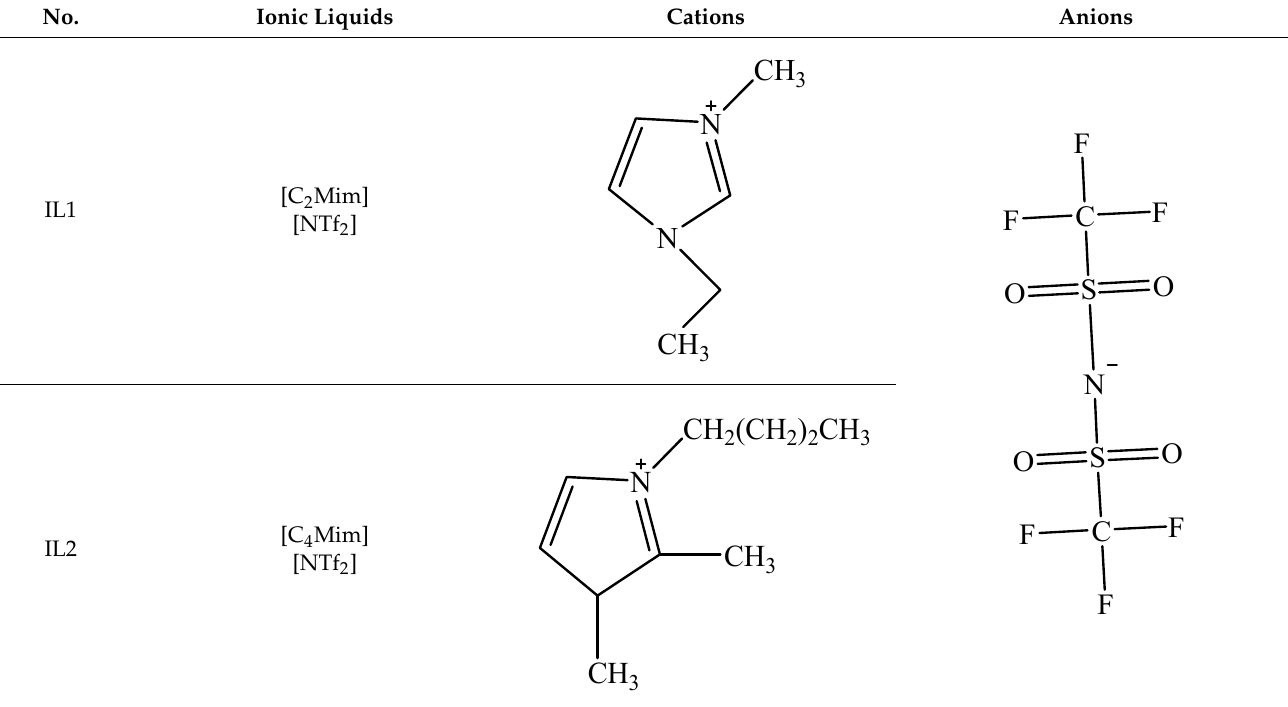
Table 2. Chemical Structure of the cations and the imide anion of the ILs used in this work with their abbreviations.